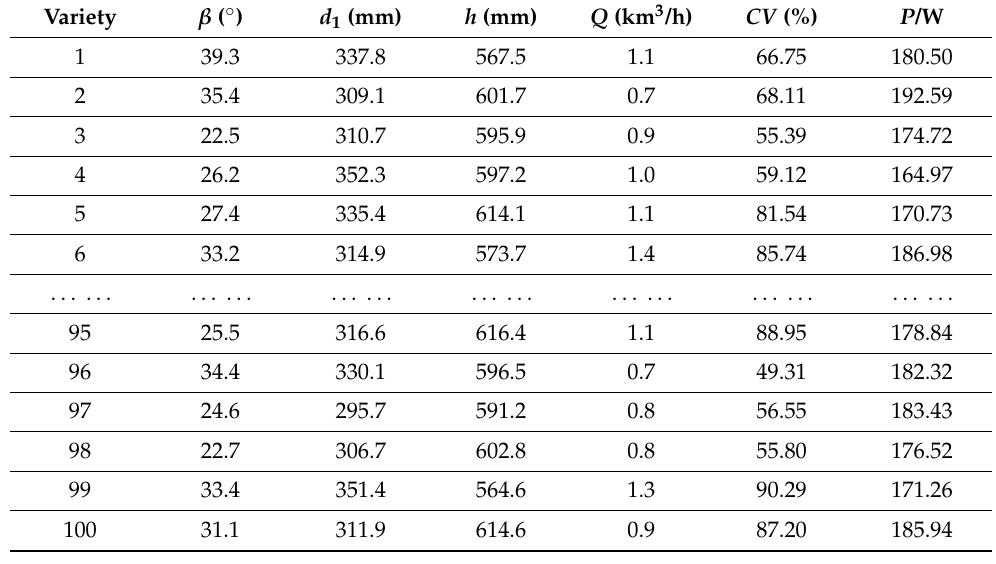
Table 3. Latin hypercube sampling and numerical calculation table.